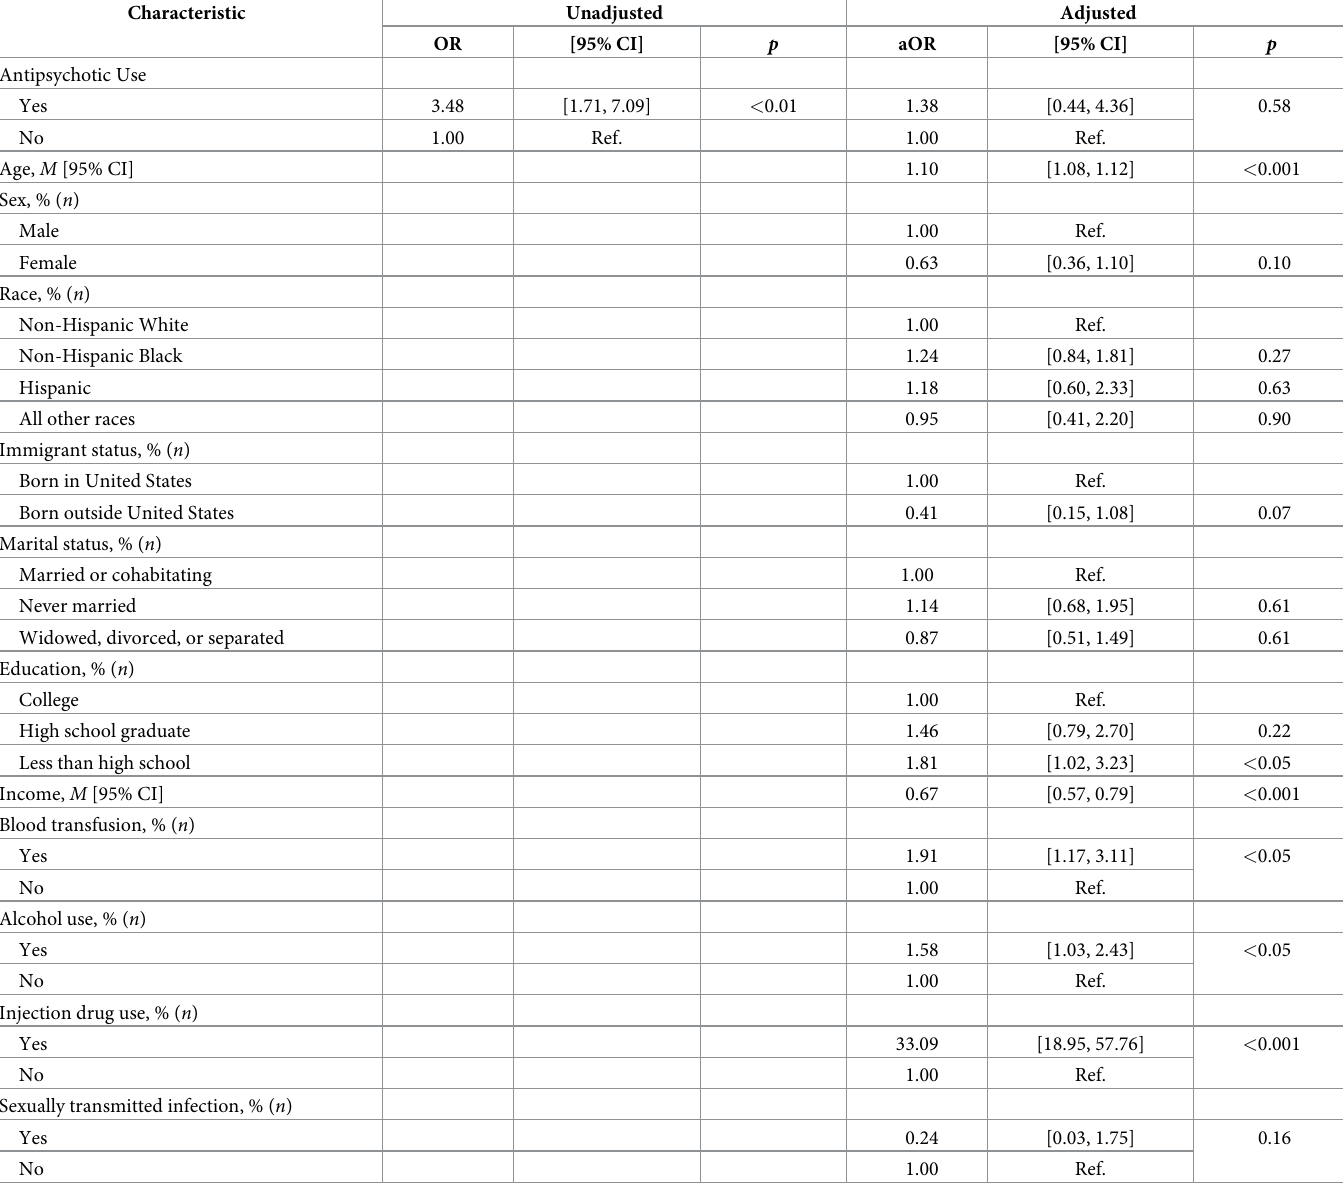
Table 3. Unadjusted and adjusted prevalence odds ratios, with 95% confidence intervals (CI), of the association between antipsychotic medication use and antibody to hepatitis C virus (HCV) among respondents to the 2005–2014 National Health and Nutrition Examination Survey ( n = 12,722).